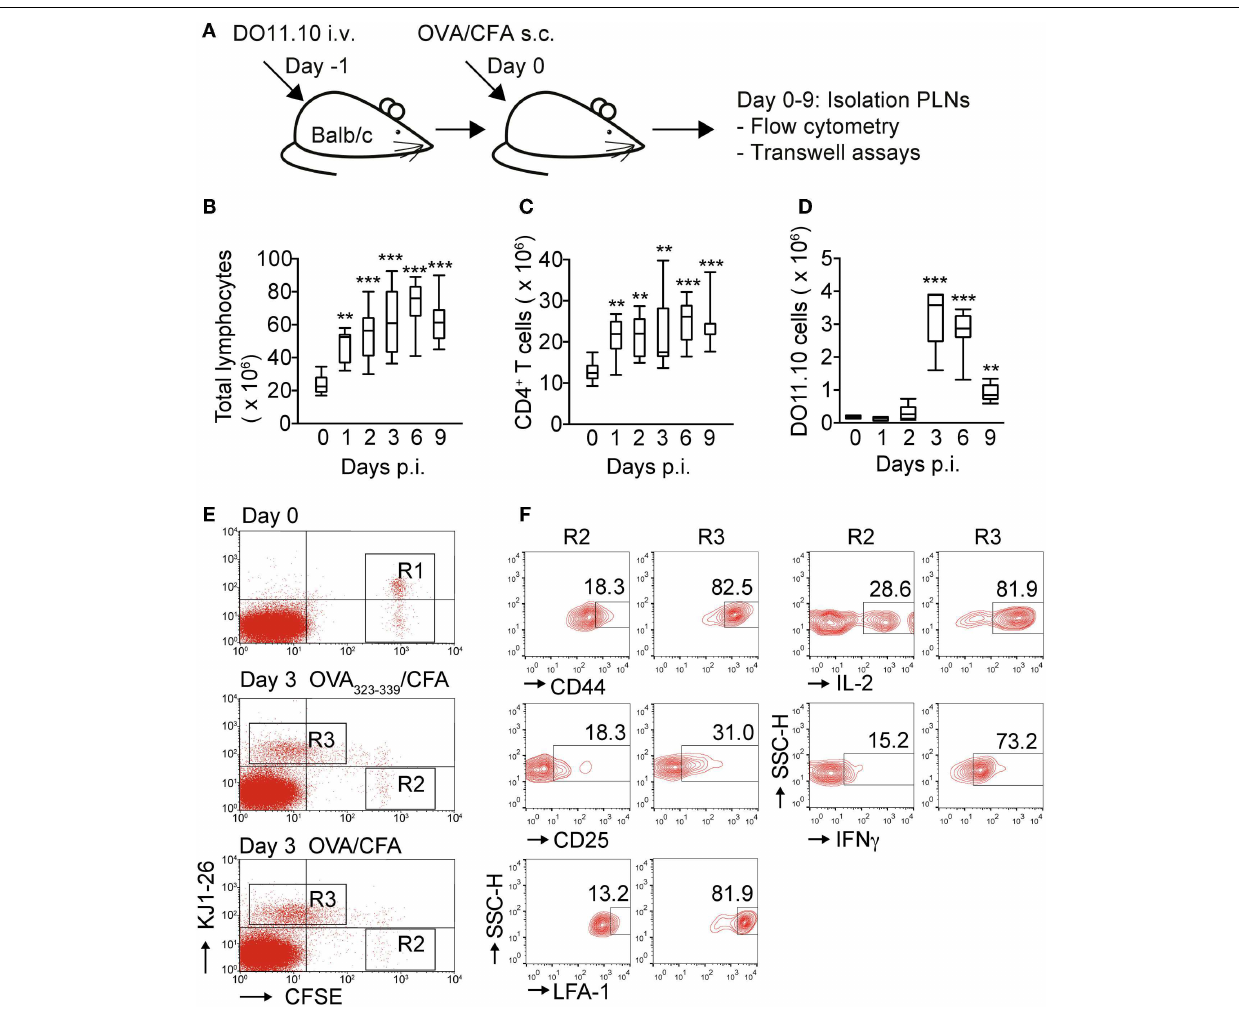
FIGURE 1 | Kinetic of DO11.10 CD4 + T cell expansion and activation after OVA/CFA immunization . (A) Outline of experiment. DO11.10 CD4 + T cells were adoptively transferred 1day before s.c. OVA/CFA immunization. Draining PLNs were analyzed by flow cytometry and chemotaxis. (B) Total pooled PLN lymphocyte numbers during OVA/CFA immunization. (C) Total CD4 + T cell numbers in pooled PLNs during OVA/CFA immunization. (D) Total KJ1–26 + CD4 + T cell numbers in pooled PLNs during OVA/CFA immunization. (E) Representative flow cytometry plots of adoptively transferred CFSE-labeled KJ1–26 (cid:0) and KJ1–26 + cells on day 0 (top panel; R1) and on day 3 post OVA peptide/CFA (middle panel) or OVA/CFA